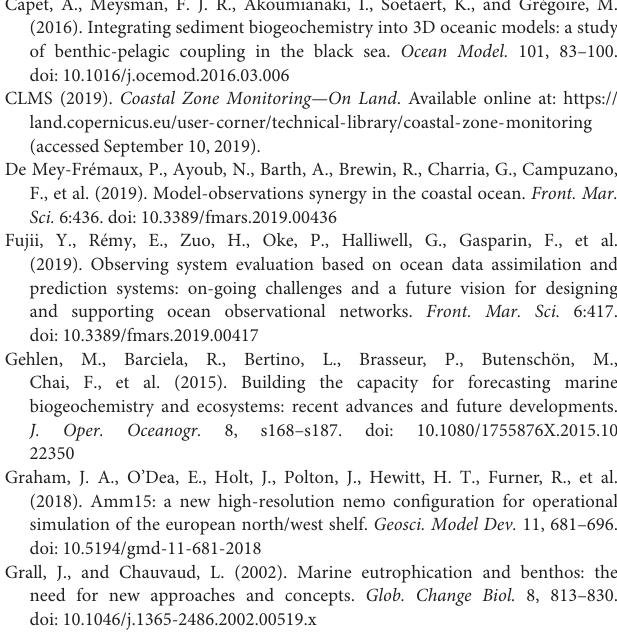
Figure S1 | Regional map - Black Sea. Figure S2 | Regional map - Baltic (BOOS). Figure S3 | Regional map - Iberian Biscay Irish Shelf (IBI). Figure S4 | Regional map - Mediterranean Sea (MONGOOS). Figure S5 | Regional map - North Sea & North-West Atlantic Shelf (NOOS). Figure S6 | Regional map - Arctic